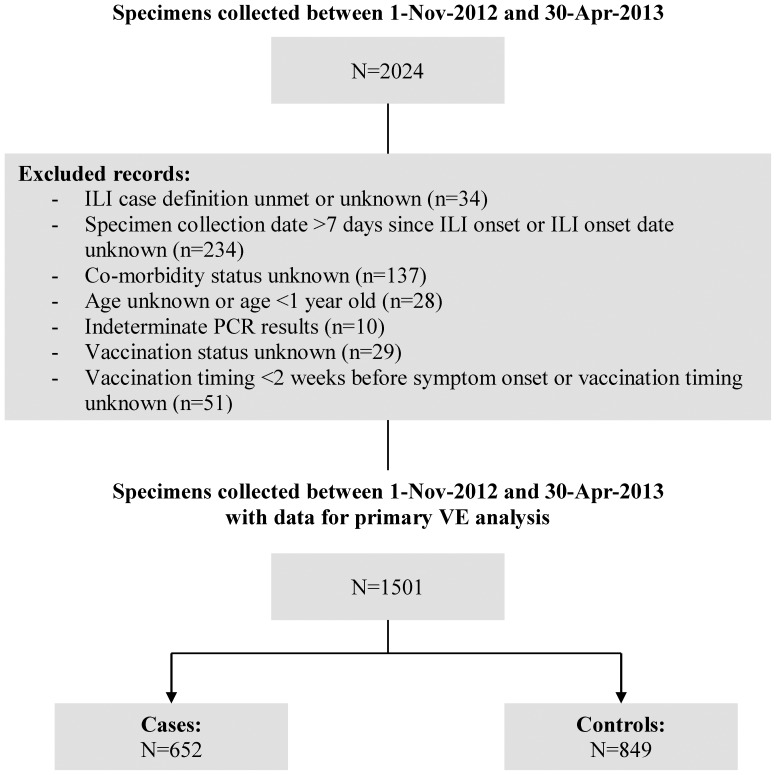
Specimen exclusion for influenza vaccine effectiveness analysis, Canada, 2012–13 sentinel surveillance system.NOTE: exclusions shown here in stepwise fashion to arrive at total case and control tally (i.e. those meeting multiple exclusion criteria are counted on the basis of the first exclusion criterion met in the list shown). Missing collection dates were imputed as the laboratory accession date minus two days, the average time period between collection date and laboratory accession date for records with valid data for both fields.